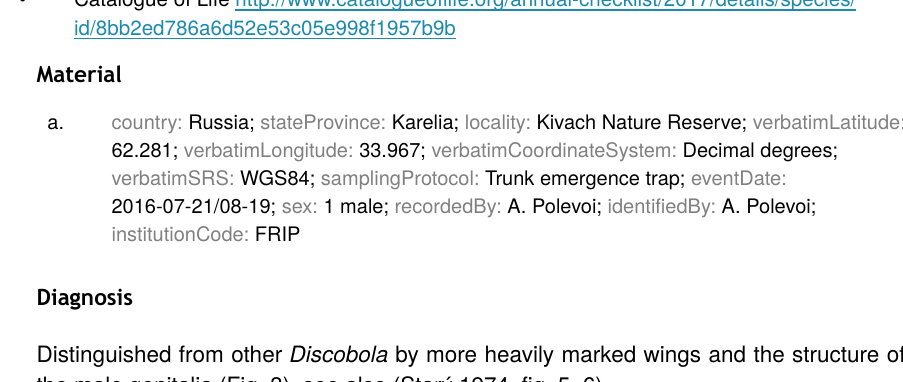
Figure 2. Atypophthalmus machidai (Alexander), male genitalia. Scale bar: 0.2 mm. a : Dorsal view. b : Ventral